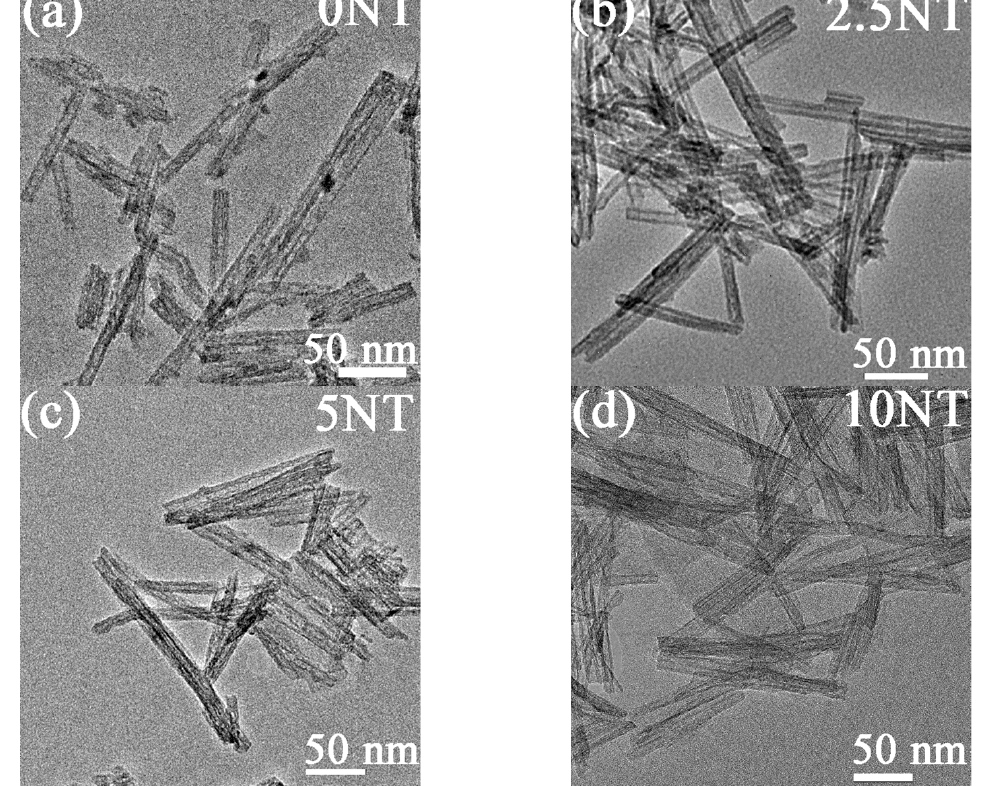
Figure 1 . TEM morphologies of the nanotubes doped with different amounts of Ce. ( a ) Undoped; ( b ) 2.5 mol%; ( c ) 5 mol%; ( d ) 10 mol%.